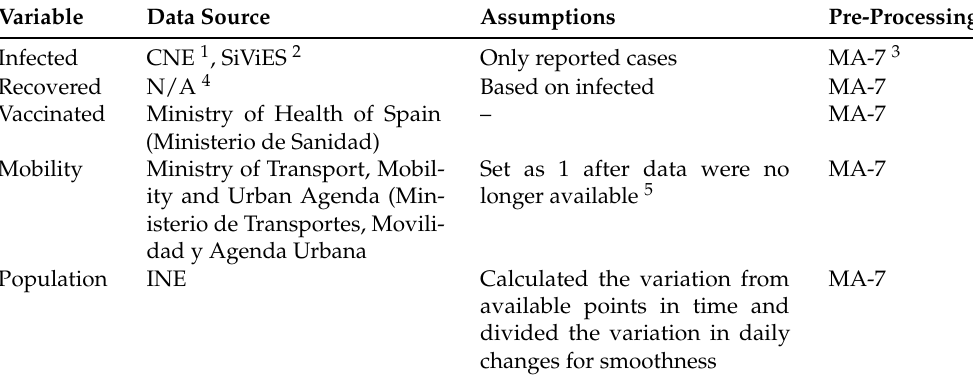
Table 1. Data sources, assumptions, and pre-processing